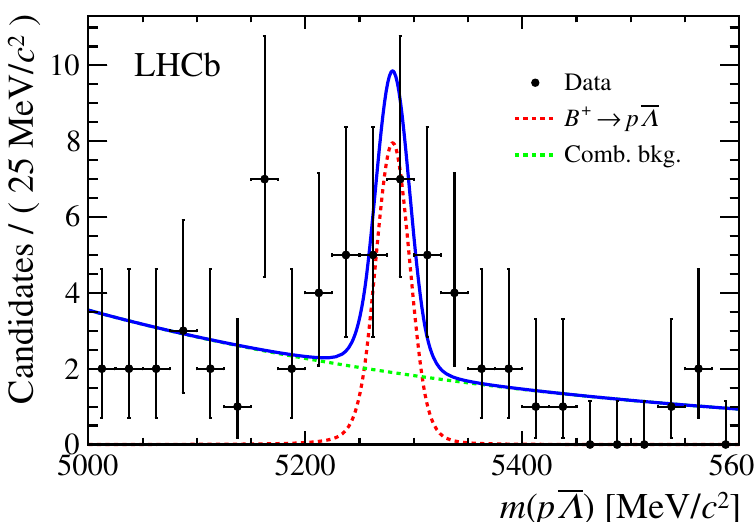
Figure 1 . Invariant mass distribution of p(cid:3) candidates after full selection. The result of the (cid:12)t to the data (blue, solid) is shown together with each (cid:12)t model component, namely the B + ! p(cid:3) signal and the combinatorial